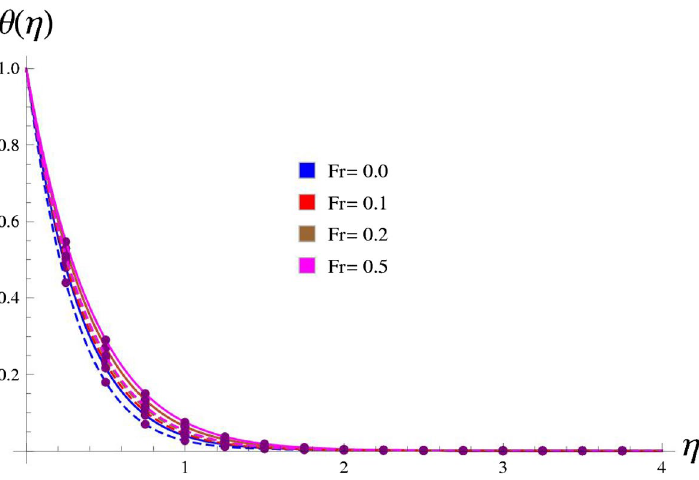
Figure 7. Behavior of temperature θ(η) against Fr = 0.0, 0.1, 0.2, 0.5.